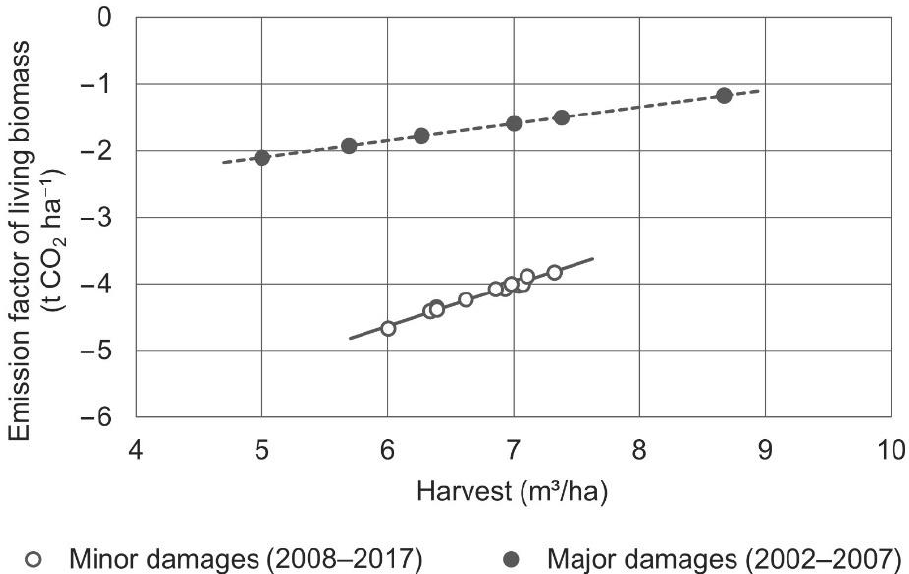
Figure 1. Relation between the emission factor of living biomass in German forests and wood harvest for a period with major storm and drought damage (dotted line, y = − 0.253 x + 3.363; r 2 = 1.000; p < 0.001) and for a period with minor damage (solid line, y = − 0.620 x + 8.353; r 2 = 0.984; p < 0.001). Linear regression was computed in the software package R [34]. Source: Emission factor of living biomass from CRF-tables adopted from [6], harvest rate adopted from [10].